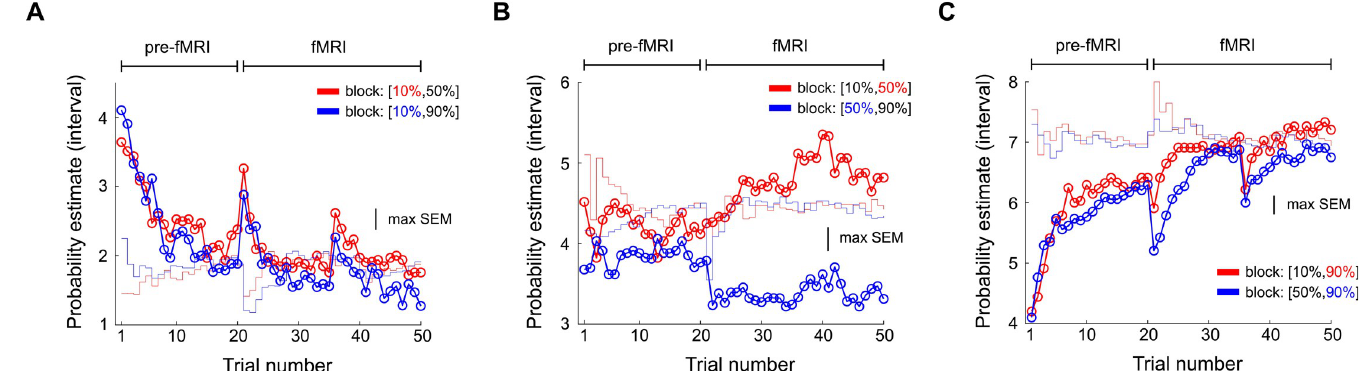
Fig 4. Experiment 1: Comparison of trial-by-trial probability estimates between contexts showing how differences in probability estimates between contexts developed during the experiment. Data includes the pre-fMRI practice session and the fMRI session. (A–C) The scale on the vertical axis indicates interval estimate (from 1 to 8 with 1 representing the smallest probability interval [0%–5%] and 8 representing the largest probability interval [95%–100%]). (A) Comparison of the 10% reward stimuli between contexts. Each data point represents the mean probability estimate of a single trial across subjects. Red: 10% stimulus in the [10%, 50%] context. Blue: 10% stimulus is in the [10%, 90%] context. The colored step function traces represent the corresponding mean frequency of reward the subjects experienced. (B) Comparison of the 50% reward stimuli between contexts. Red: 50% stimulus in the [10%, 50%] context. Blue: 50% stimulus in the [50%, 90%] context. (C) Comparison of the 90% reward stimuli between contexts. Red: 90% stimulus in the [10%, 90%] context. Blue: 90% stimulus in the [50%, 90%] context. The bumps on trial number 21 and 36, seen in Fig 4A and 4C, reflect the beginning of a new block of trials. Data underlying these graphs can be found in https://osf.io/48j7m. fMRI, functional magnetic resonance